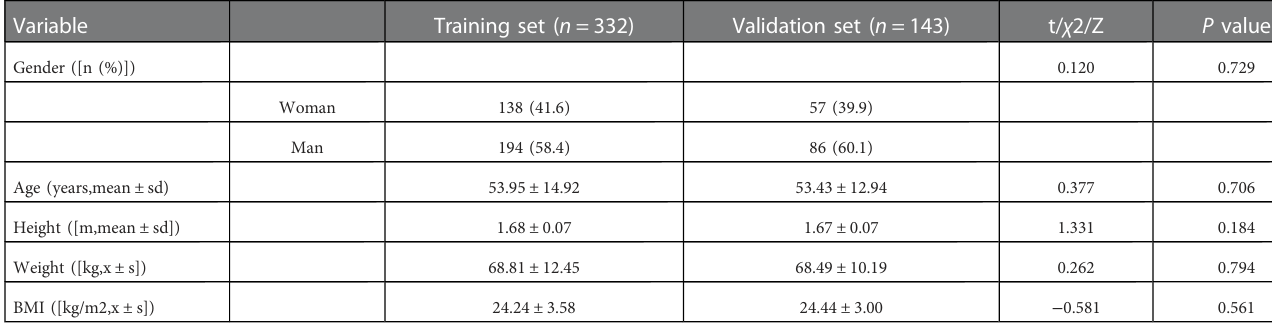
TABLE 1 Comparison of baseline characteristics of